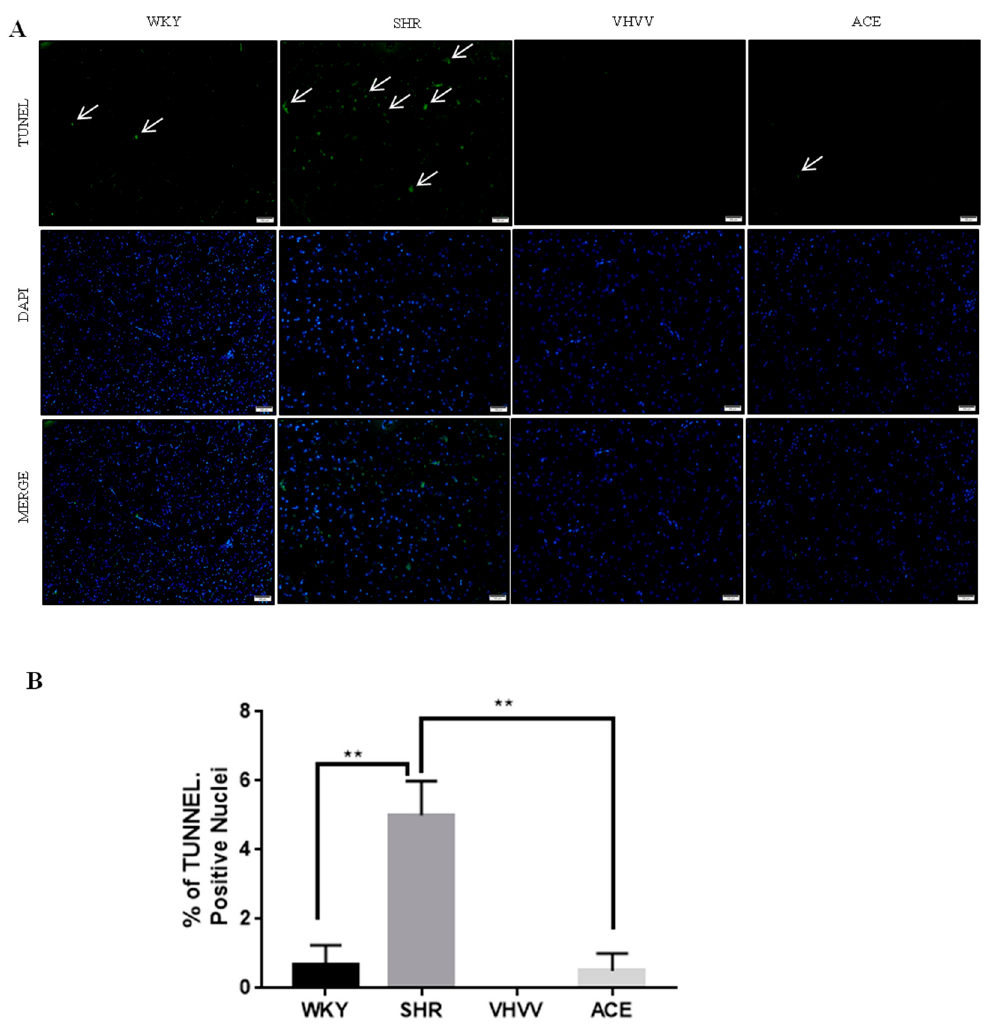
Figure 5. Photomicrographs of terminal deoxynucleotidyl transferase dUTP nick end labeling (TUNEL) staining in the experimental groups are shown. ( A ) Sections were labeled with TUNEL (green) to assess apoptotic brain cells. Sections were counterstained with DAPI (blue) to detect the nuclei. The arrowhead of SHR indicates TUNEL-positive cells; however, there is no TUNEL-positive cells in WKY and VHVV and a fewer number of positive cells in ACE. Scale bar showed as 100 µ M. ( B ) Quantification of Figure 5A by image J software. ** p <